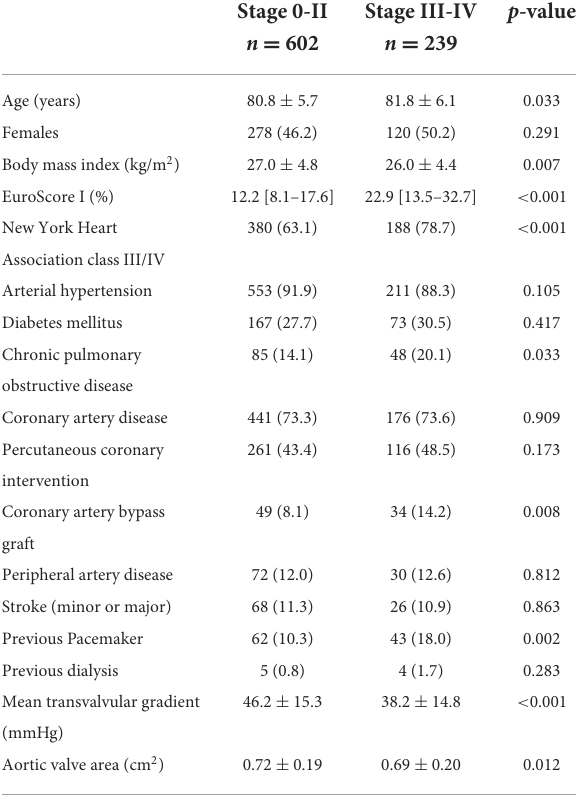
TABLE 2 Baseline characteristics according to dichotomized stages of cardiac